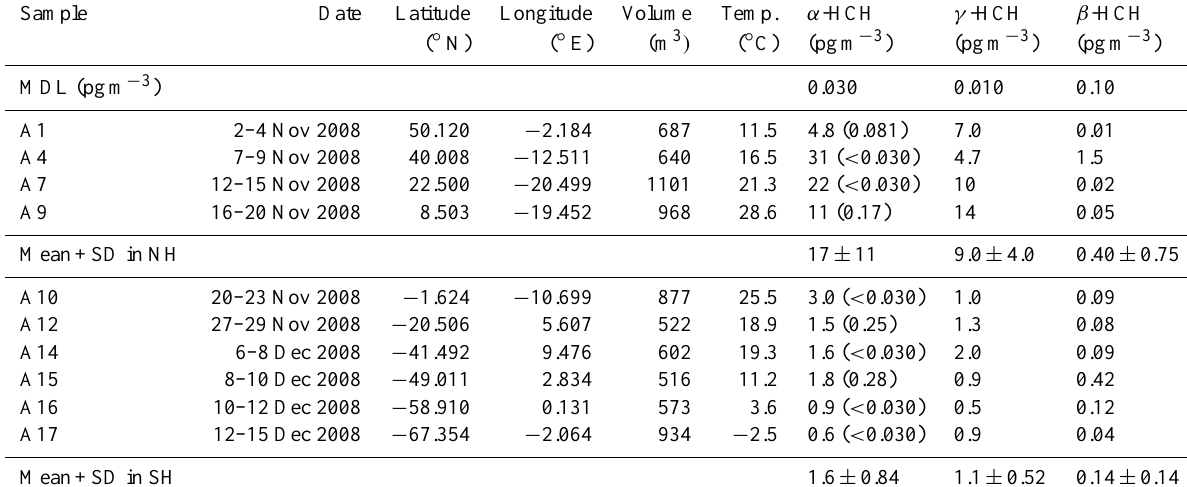
Table 1. Individual concentrations of HCHs in the atmosphere (pgm − 1 ) in the Atlantic and the Southern Ocean. Concentrations of α -HCH in atmospheric particle phase are showed in the blanket, and γ -HCH and β -HCH are below the method detection limits. Sample Date Latitude Longitude Volume